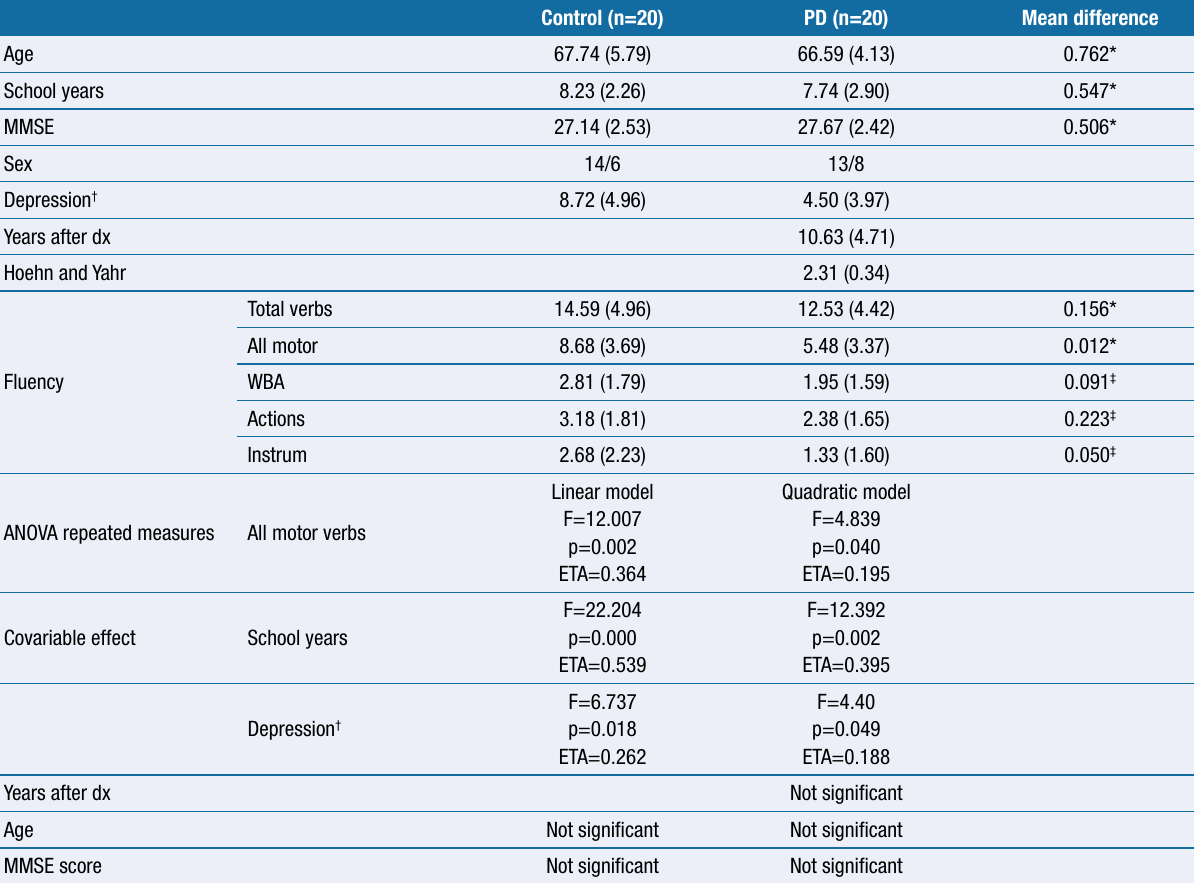
Table 1. Demographic data, mean differences, and ANOVA (repeated measures).